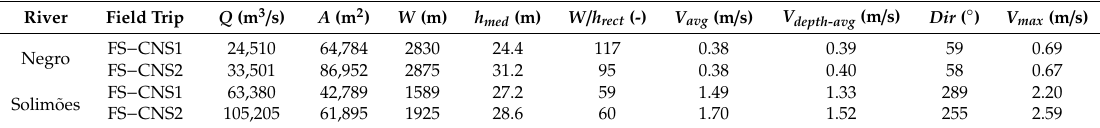
Table 2. Main flow properties of Negro and Solim õ es Rivers during FS − CNS1 / FS − CNS2 / FS − CNS3. Q = mediandischarge; A = mediancross-sectionalarea; W = channelmedian width; h med = mediandepth; W / h rect = median of the aspect ratio; V avg = median of the cross-section velocity ( Q / A ); V depth-avg = median of the depth-averaged velocity; Dir = median of flow direction degrees from North; V max = maximum depth-averaged